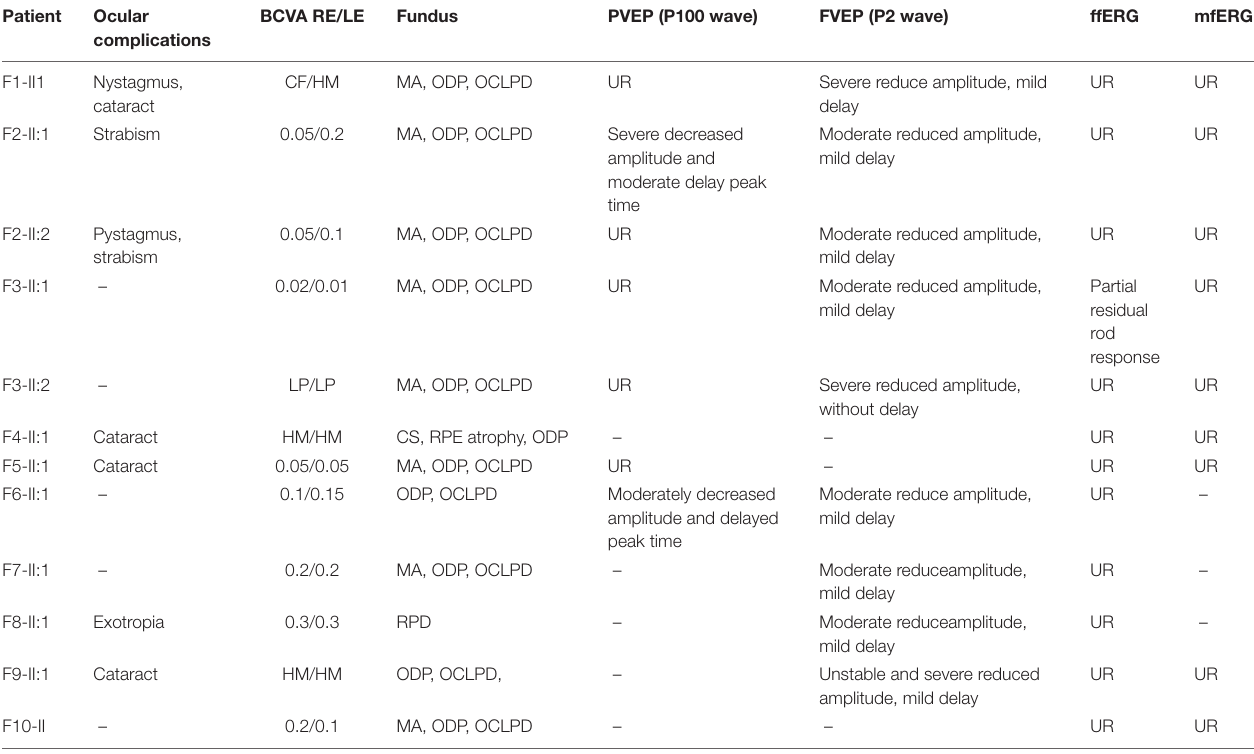
TABLE 2 | Fundus manifestation and evaluation of visual function in patients with BBS. Patient